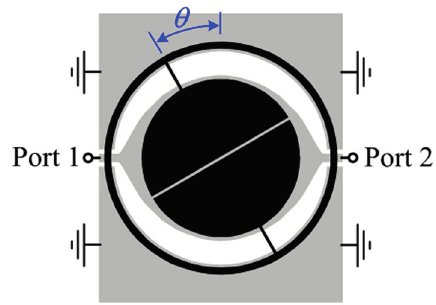
Figure 11. Layout of the circular-shaped ELC-loaded CPW structure (for a specific angle of 30°). The considered substrate is Rogers RO3010 with h = 1.27 mm and ε r = 11.2. The dimensions are: for the line, W and G are tapered such that the characteristic impedance is 50 Ω ; for the ELC resonator: mean radius r 0 = 8.05 mm, capacitor outer radius r 1 = 11 mm, w 2 = s = 0.2 mm, and w 3 = 0.5 mm.